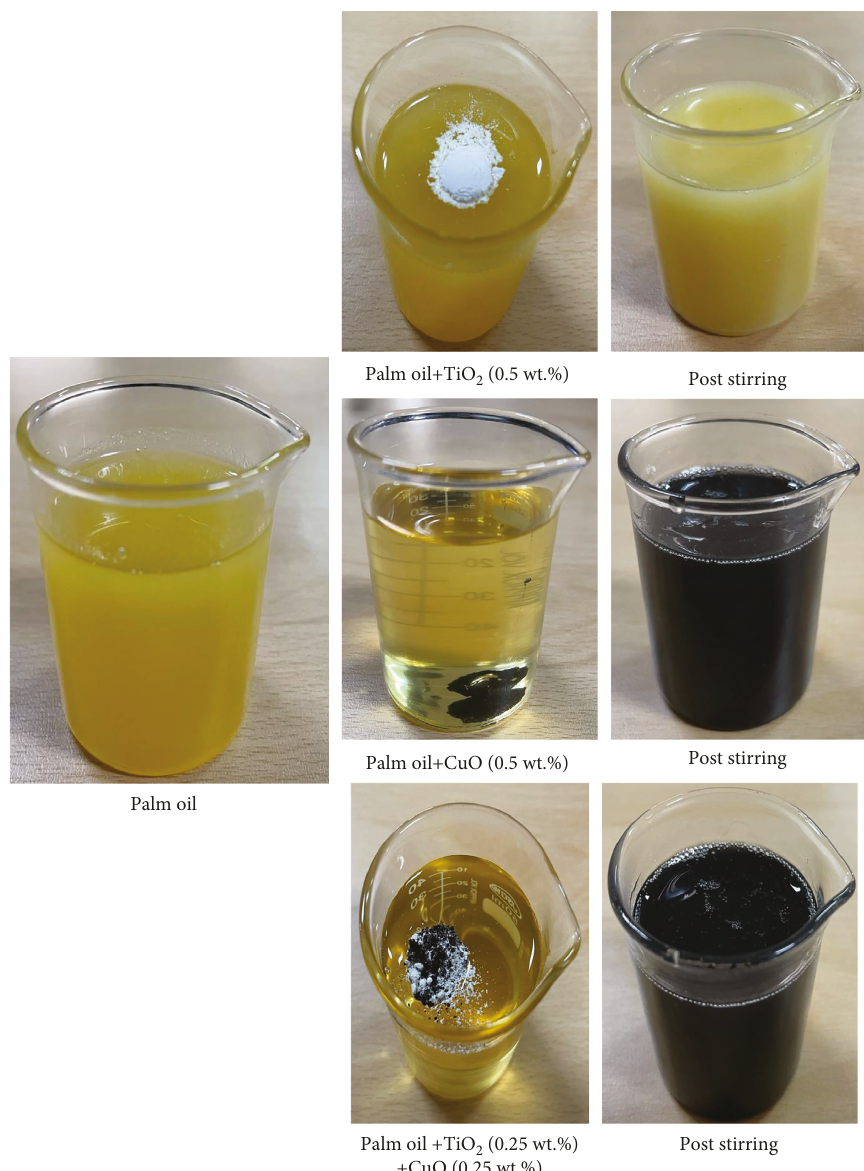
Figure 6: Preparation of nano